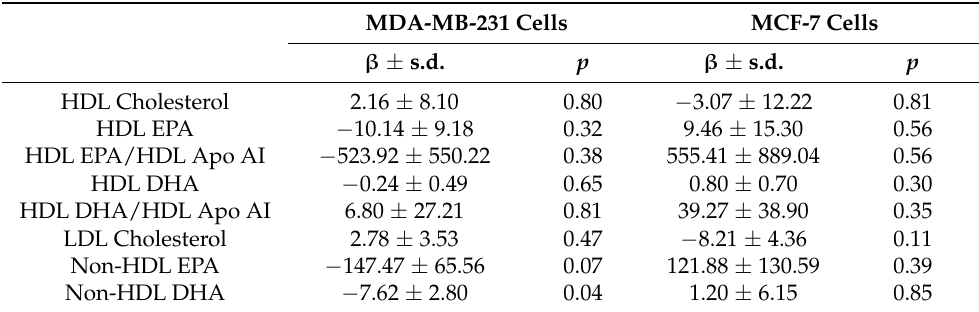
Table 4. Correlation between lipoproteins, omega-3 fatty acids carried by lipoproteins and in vitro